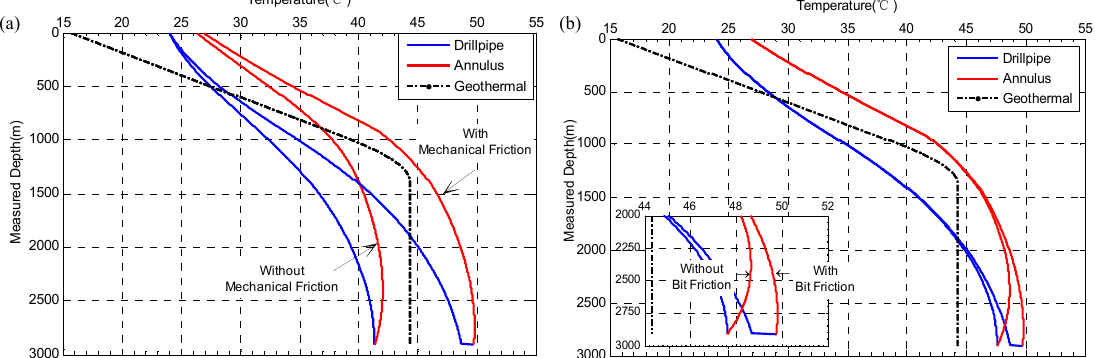
Figure 11. Wellbore temperature profile ( a ) with and without total mechanical friction ( b ) with and without considering the effect of mechanical friction on the drill bit (RPM = 100 r/min). The rotation rate of drill pipes affected the amount of heat generated during drilling processes. In Figure 12, without considering the effect of rotation on the convection heat transfer, the red line with circular markers and blue line with triangular markers show the temperature variations at the wellbore bottom when the heat source at the drill bit was taken into account and excluded, respectively. In both cases, it was evident that the wellbore bottom temperature in the annulus